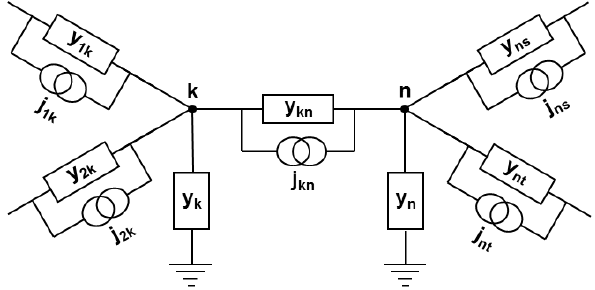
Figure 3. Schematic of admittance network for modelling